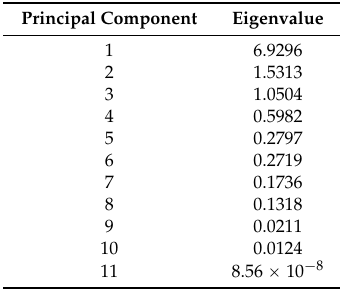
Table 1. Eigenvalues associated with the principal components after elaboration of the whole dataset considering both the control ( n = 5) and permethrin (PERM) ( n = 4) groups.